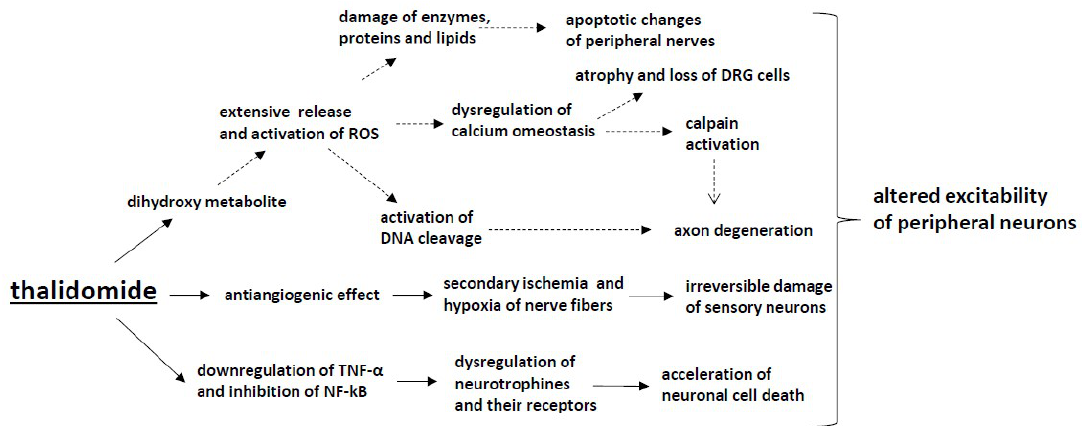
Figure 2. The mechanisms of CIPN induced by thalidomide: Thalidomide downregulates TNF- α and inhibits NF- κ B, which leads to the dysregulation of neurotrophins and their receptors and, in consequence, accelerates neuronal cell death. Moreover, the antiangiogenic effect induced by thalidomide causes secondary ischemia and hypoxia of nerve fibres and, subsequently, irreversible damage of sensory neurons. The activation of the dihydroxy metabolite of thalidomide causes the extensive release and activation of ROS and activates DNA cleavage, though further preclinical and clinical trials are needed to confirm the presence of such a mechanism in thalidomide-induced peripheral neuropathy.